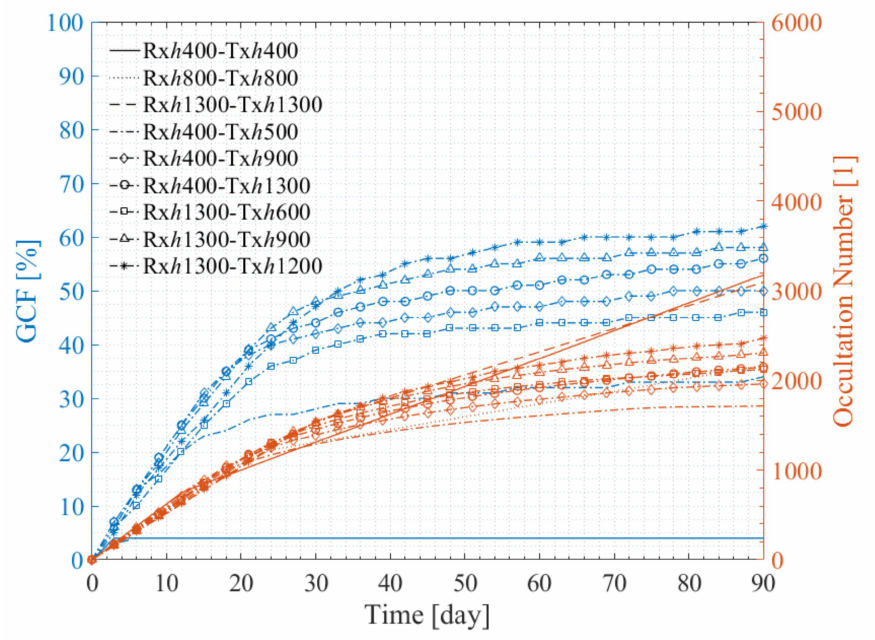
Figure 10. The accumulated time dependence of the LEO-LEO occultation event number (orange lines) and the global coverage fraction (GCF) (blue lines) for the representative Rxi98-Txi82 constella- tions composed of a Rx satellite and a Tx satellite with particular orbital